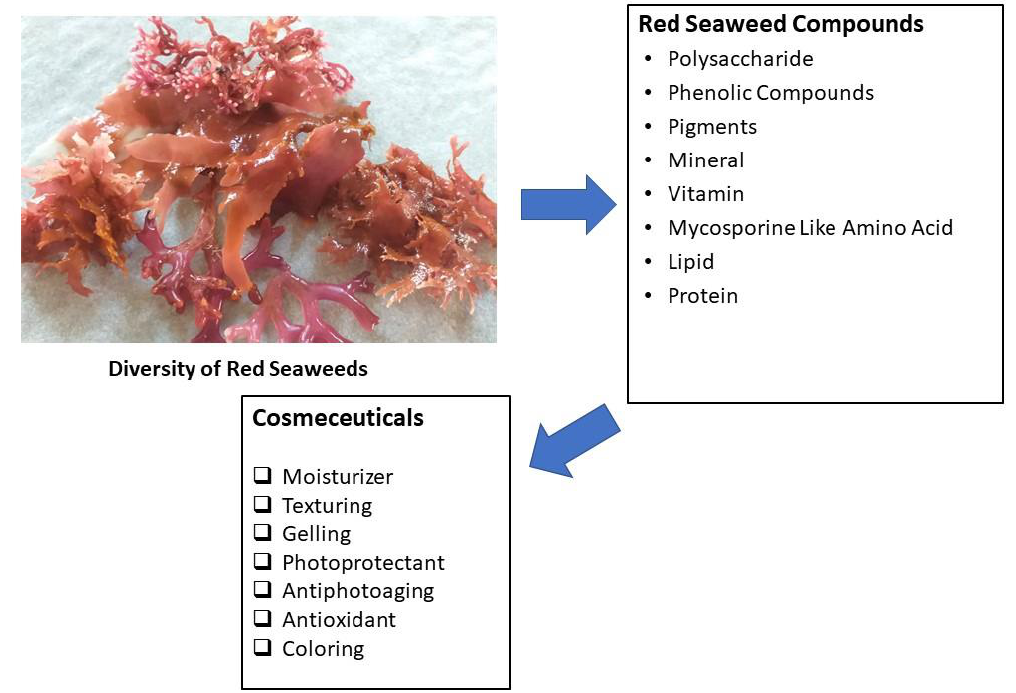
Figure 3. The diversity of red seaweeds and potential applications for cosmeceuticals. Red seaweeds have economic value and are worth billions of dollars every year. At least 125 different species of red seaweeds are used worldwide with different applications.